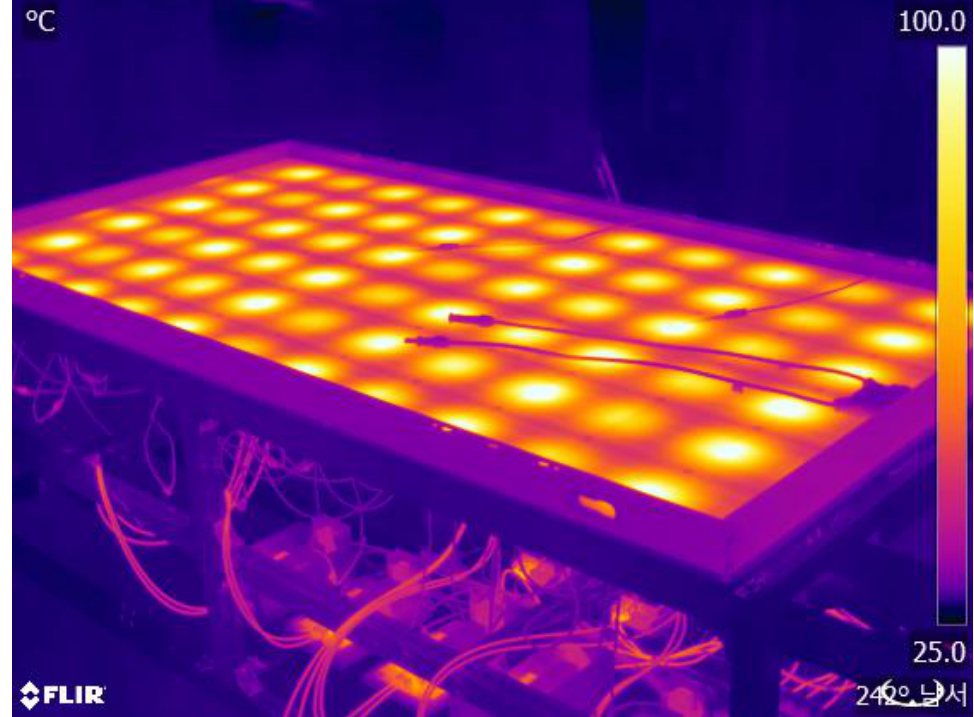
Figure 5. Thermal image of p-PERC solar module applied with remote heating technology using half-bridge resonance